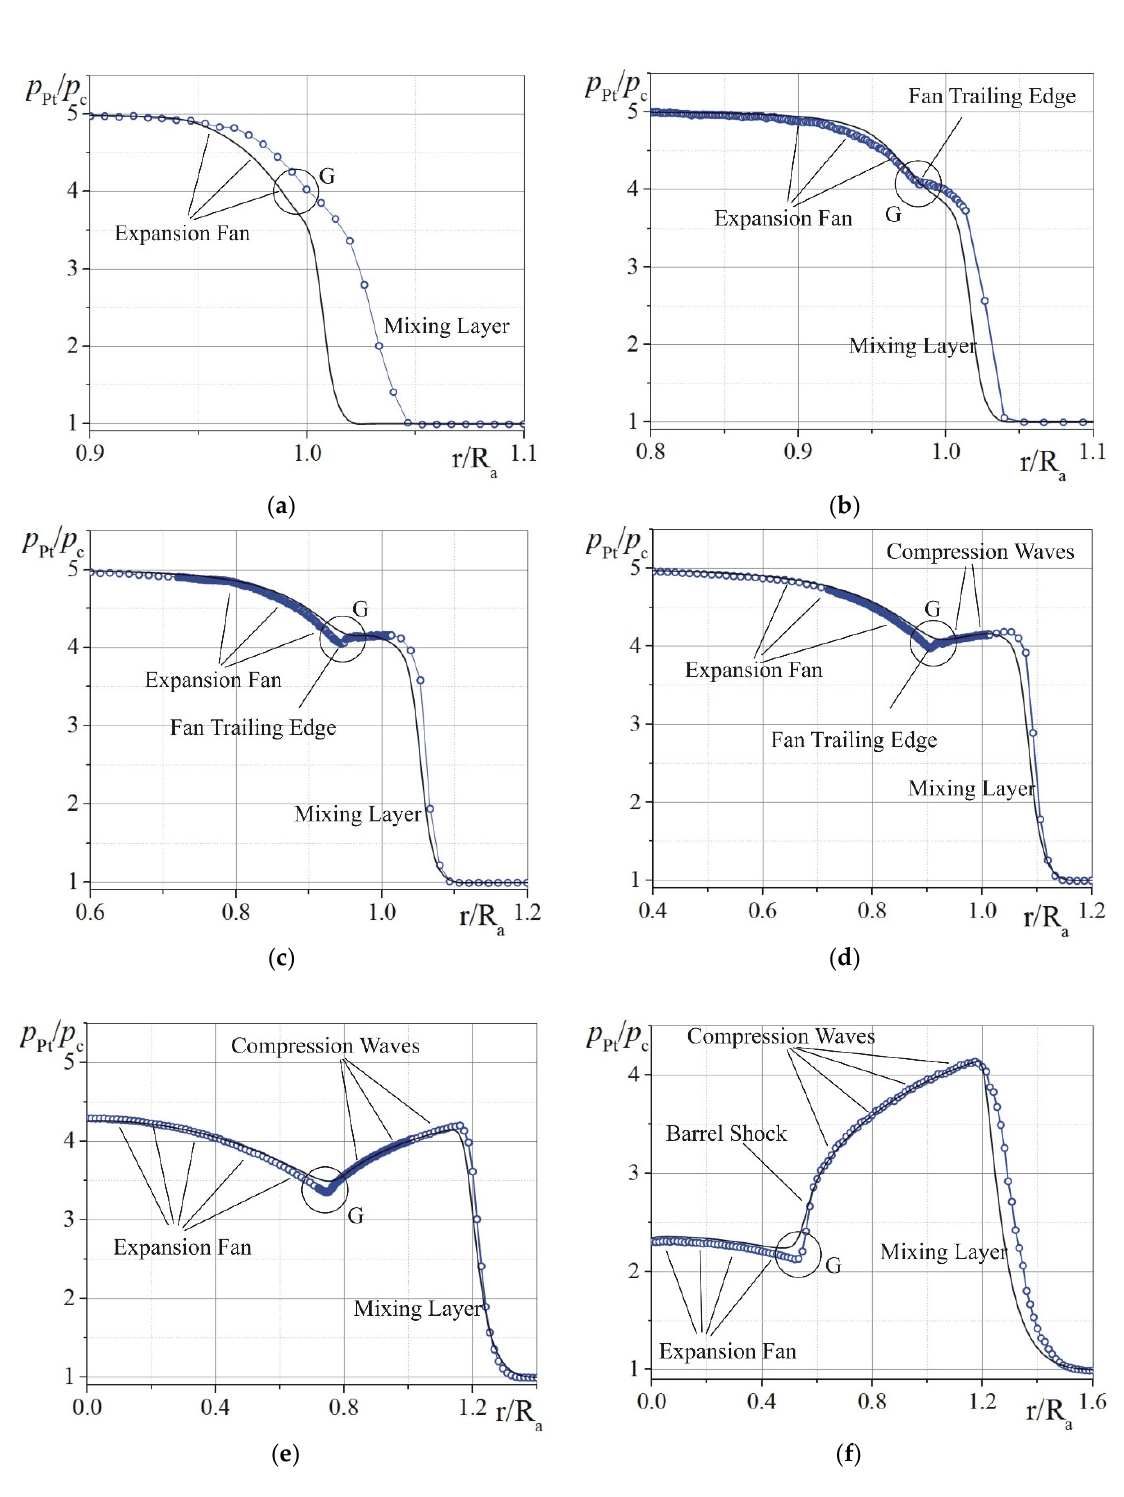
Figure 8. The radial distribution of the relative total pressure p Pt /p c obtained in the cross-sections of the jet x/R a = 0.03 ( a ), 0.07 ( b ), 0.2 ( c ), 0.33 ( d ), 1.0 ( e ), and 2.0 ( f ). The blue circles and black lines are, respectively, the experimental and numerical data.